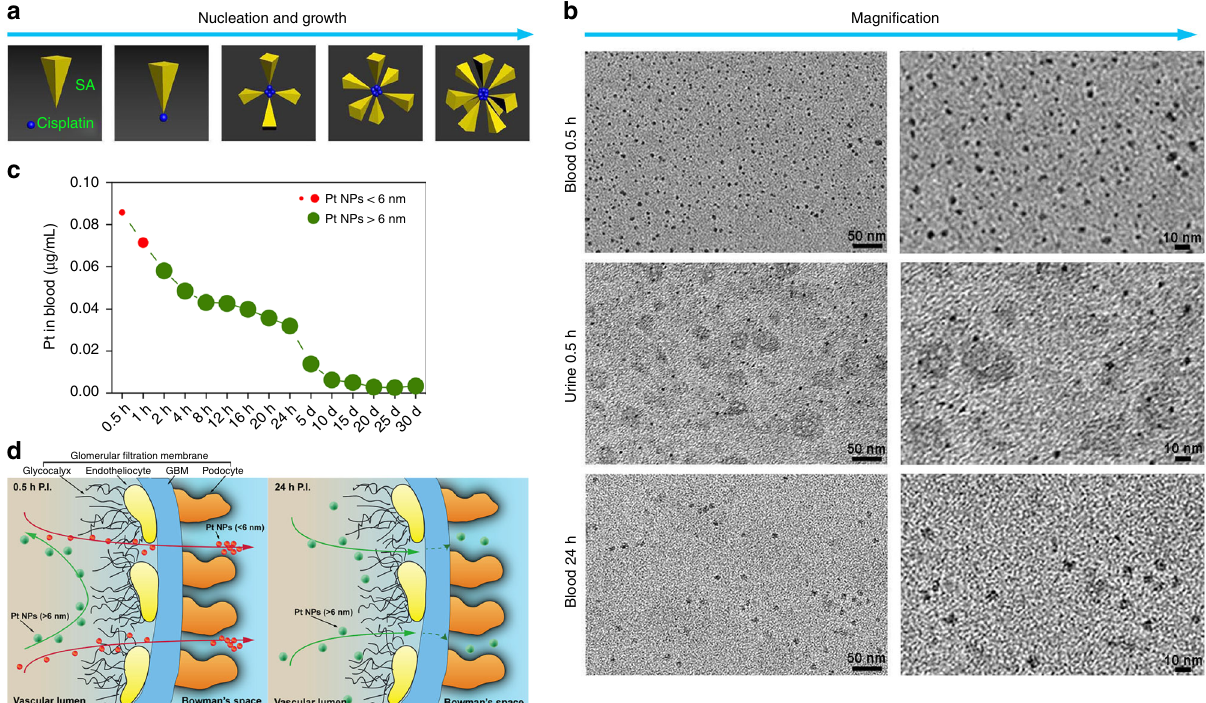
Fig. 2 Biosynthesis and metabolism of Pt NPs after cisplatin chemotherapy. a Illustration of the process of nucleation and growth of Pt NPs. b The varying sizes of Pt NPs in patient blood at 0.5 h after cisplatin treatment (top), in the urine 0.5 h after treatment (middle) and in the blood 24 h after treatment (bottom). The right panels show a higher magni fi cation. c The concentration of Pt NPs in patient blood after cisplatin chemotherapy over a 30 d period after treatment. d Illustration of the glomerular fi ltration of different sized Pt NPs; Pt NPs <6 nm more easily traverse the GBM than Pt NPs >6